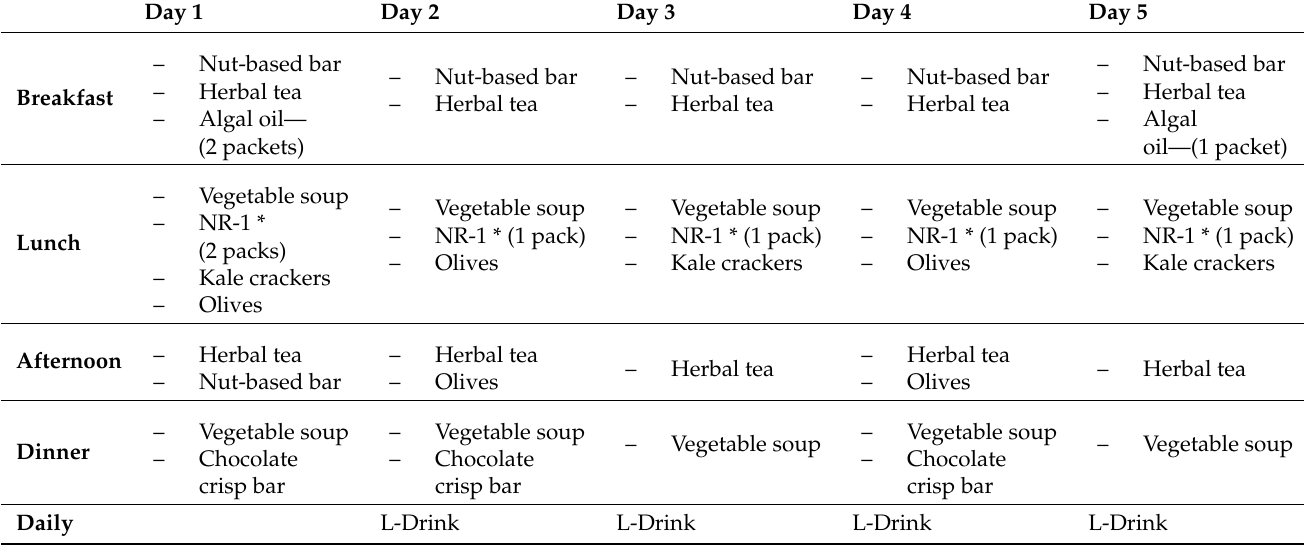
Table 1. Test products to be used on day 1, day 30, and day